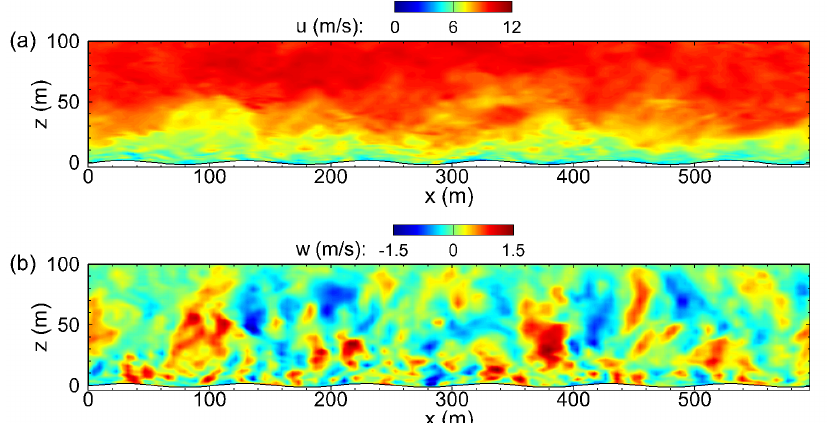
Figure 4. Instantaneous flow field on the ( x , z ) -plane across the center of the surface release region for